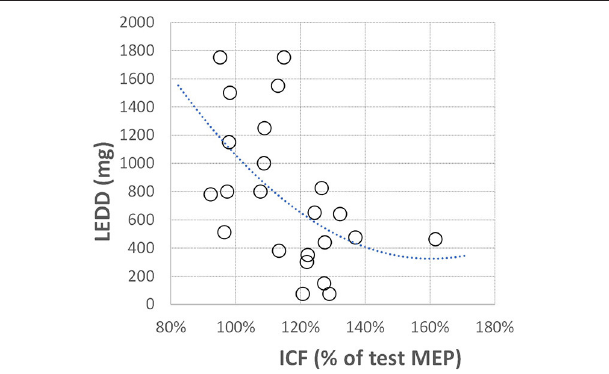
FIGURE 3 | Correlation between off-medication ICF and total daily dopaminergic medication dose expressed as levodopa equivalent daily dose (LEDD). ICF is presented the same as in Figure 1 ; LEDD is presented in milligrams. The polynomial regression line is plotted for illustrative purposes